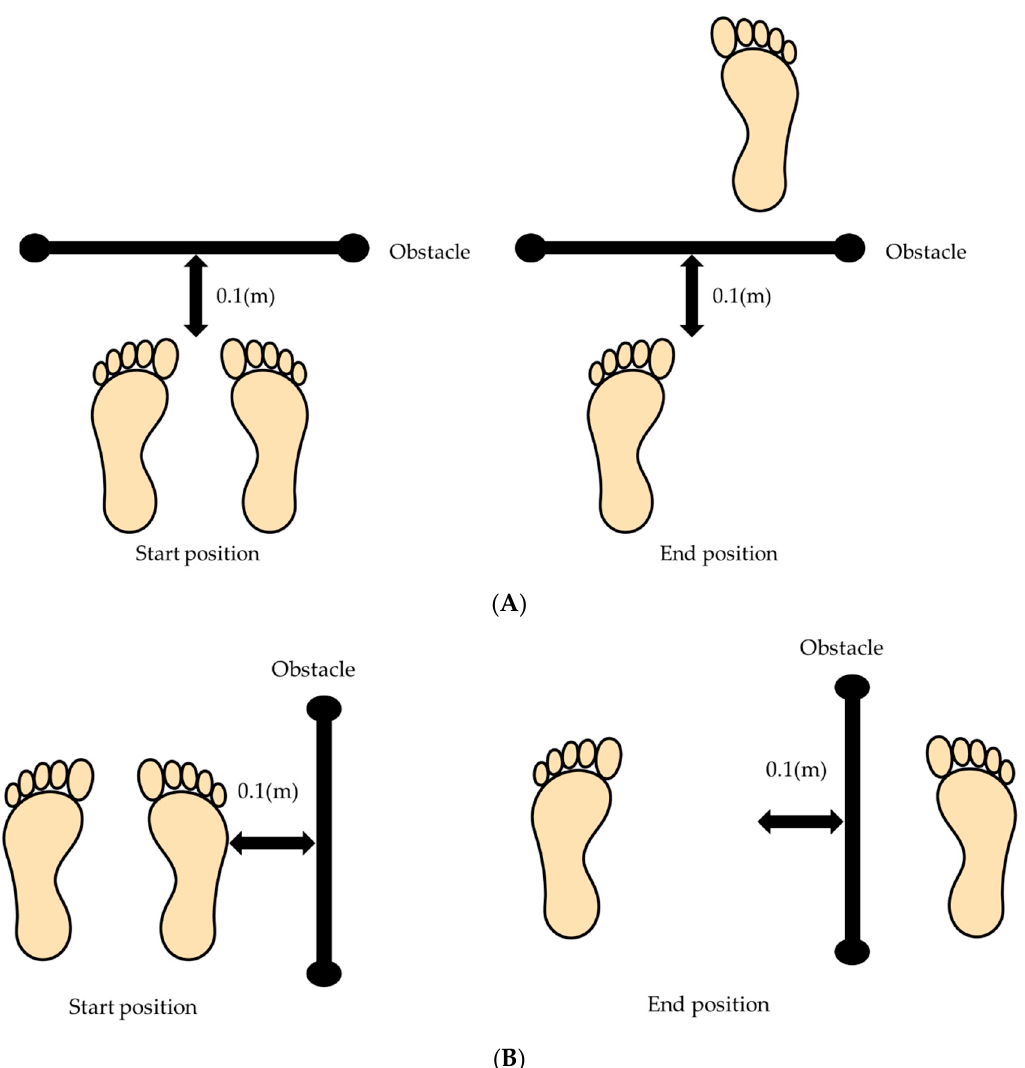
Figure 2. ( A ). The start and end foot position in the anterior crossing movement. ( B ). The start and end foot position in the lateral crossing movement.